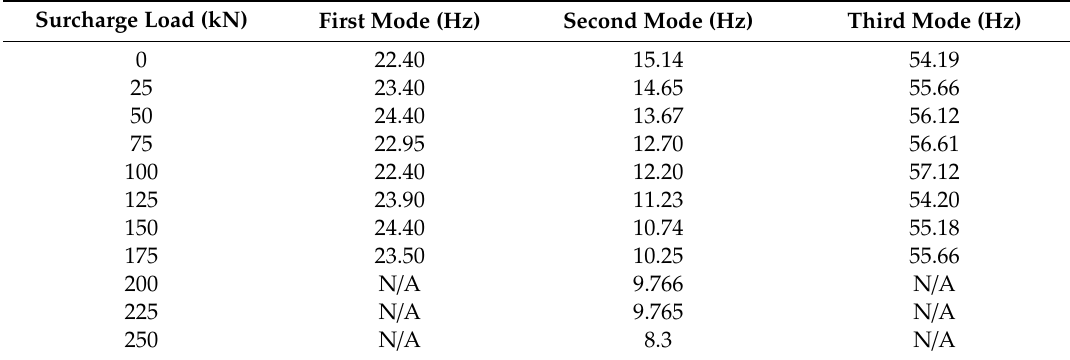
Table 2. Natural frequency results of the full-scale model pier according to the surcharge load.